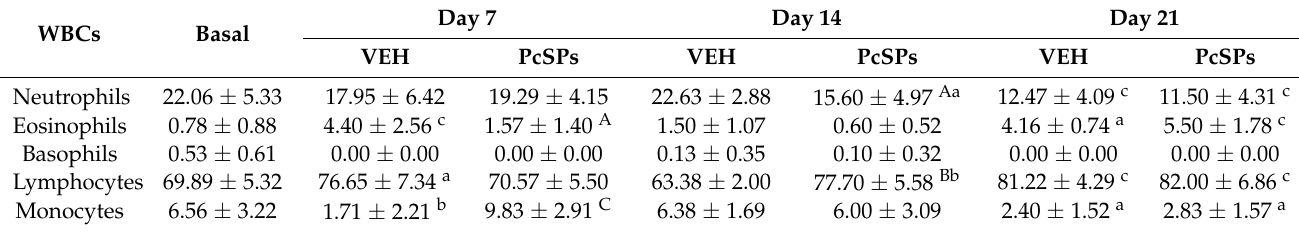
Values are given as the ± SEM ( n = 6 animals per group). Differences between groups were evaluated using One-way ANOVA and Boferroni’s multiple comparisons test: ( a ) p < 0.05, ( b ) p < 0.01 and ( c ) p < 0.001 vs. Basal group, ( A ) p < 0.05, ( B ) p < 0.01 and ( C ) p < 0.001 vs. VEH group.